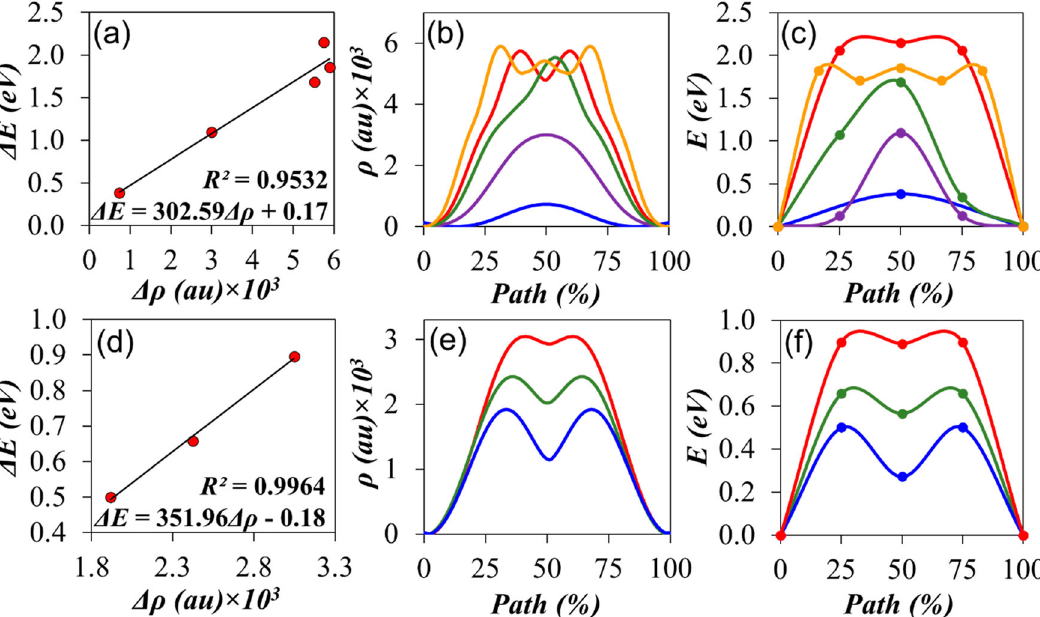
Fig. 2 Barriers and energy (density) pro fi les of MEPs (MEDPs). The plots ( a ) and ( d ) show the correlation of the energy and electron density barriers of MEPs and MEDPs representing Li-ion migration pathways in Li 3 OCl and LiTiS 2 structures. The graphs ( b , e ) and ( c , f ) are energy and electron density pro fi les of the Li 3 OCl and LiTiS 2 structures, respectively. The colors of the pro fi les correspond to the colors of gradient paths in Fig.